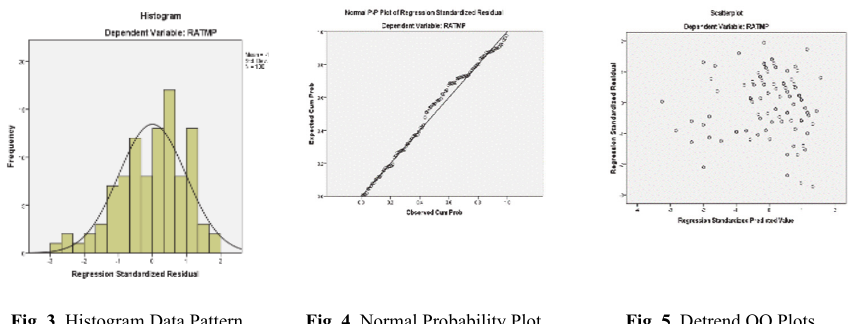
Fig. 3. Histogram Data Pattern Fig. 4. Normal Probability Plot Fig. 5. Detrend QQ